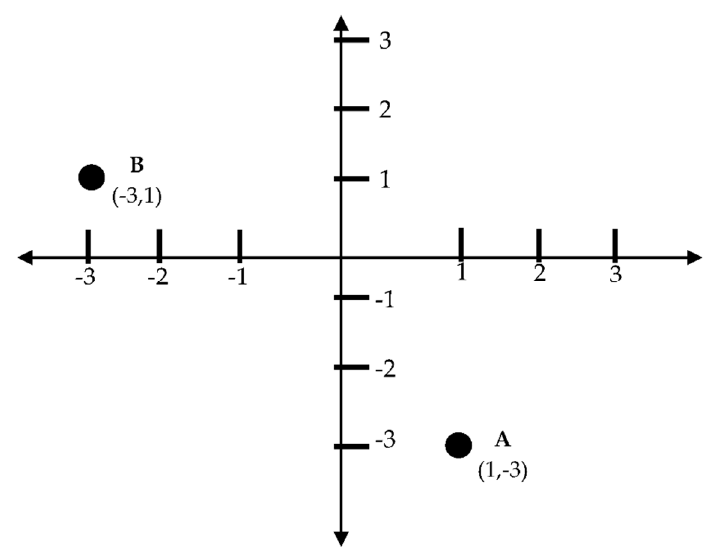
Figure 3. An illustration of mapping selected historical events of interaction between Japanese Catholics (JCs) and Filipino Catholics (FCs) manifesting inclusionary/exclusionary strategies in numerical scale.